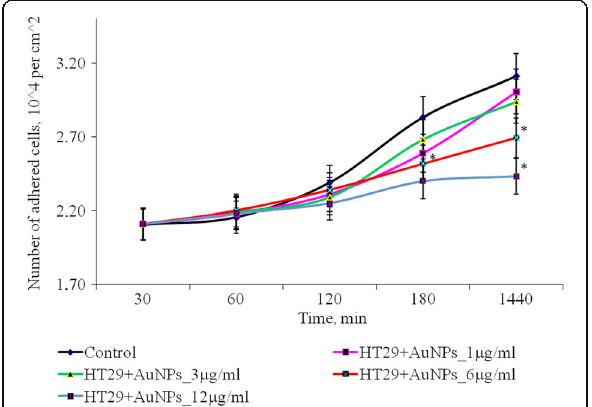
Fig. 3 Dynamics of adhesion of HT29 cells after exposure of AuNPs, * p ≤ 0.05 is significant versus with the control